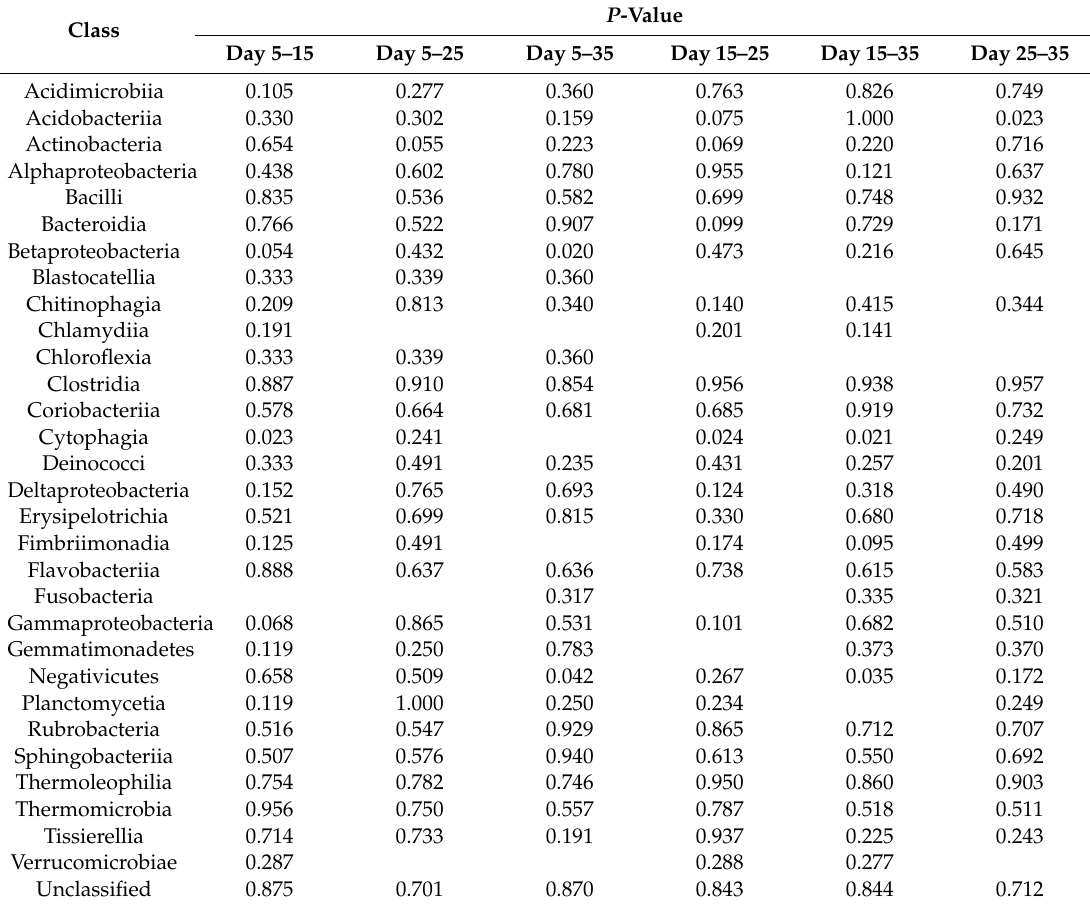
Table 6. P -value distribution of 16S rDNA gene sequence libraries compared the abundance di ff erences of microbial communities among samples from di ff erent age periods for Cobb 500 Broiler